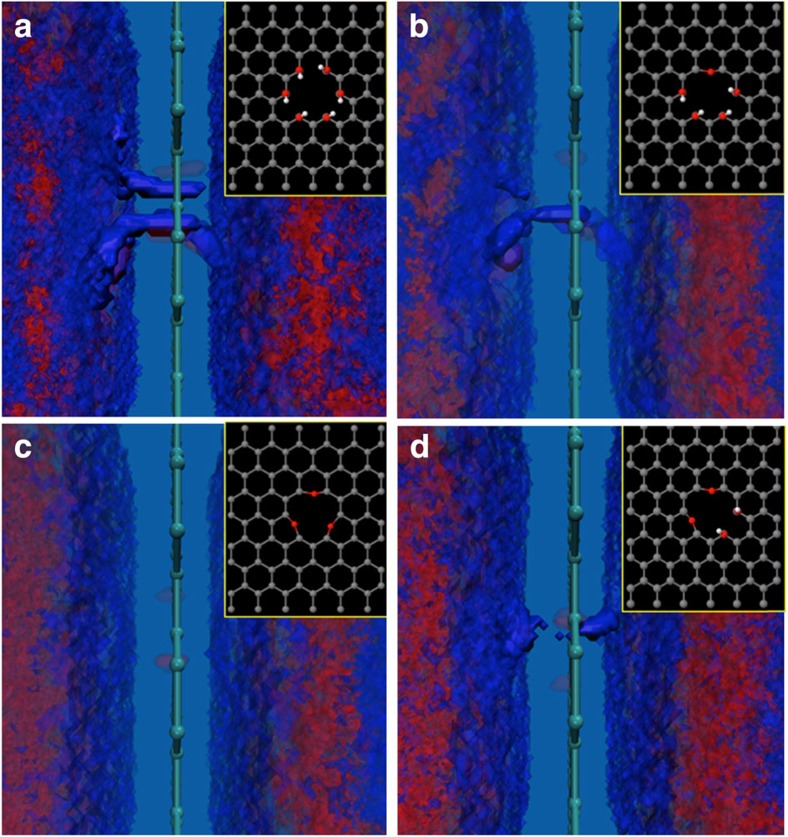
Reactive force field calculations.Proton channel formation from ReaxFF calculations of water-mediated proton transfer through atomic defects terminated in six OH groups (a), four OH groups and one oxygen atom (b), two OH groups and two oxygen atoms (c), and three oxygen atoms (d). Denotations of spheres: grey=carbon; red=oxygen; white=hydrogen atoms.